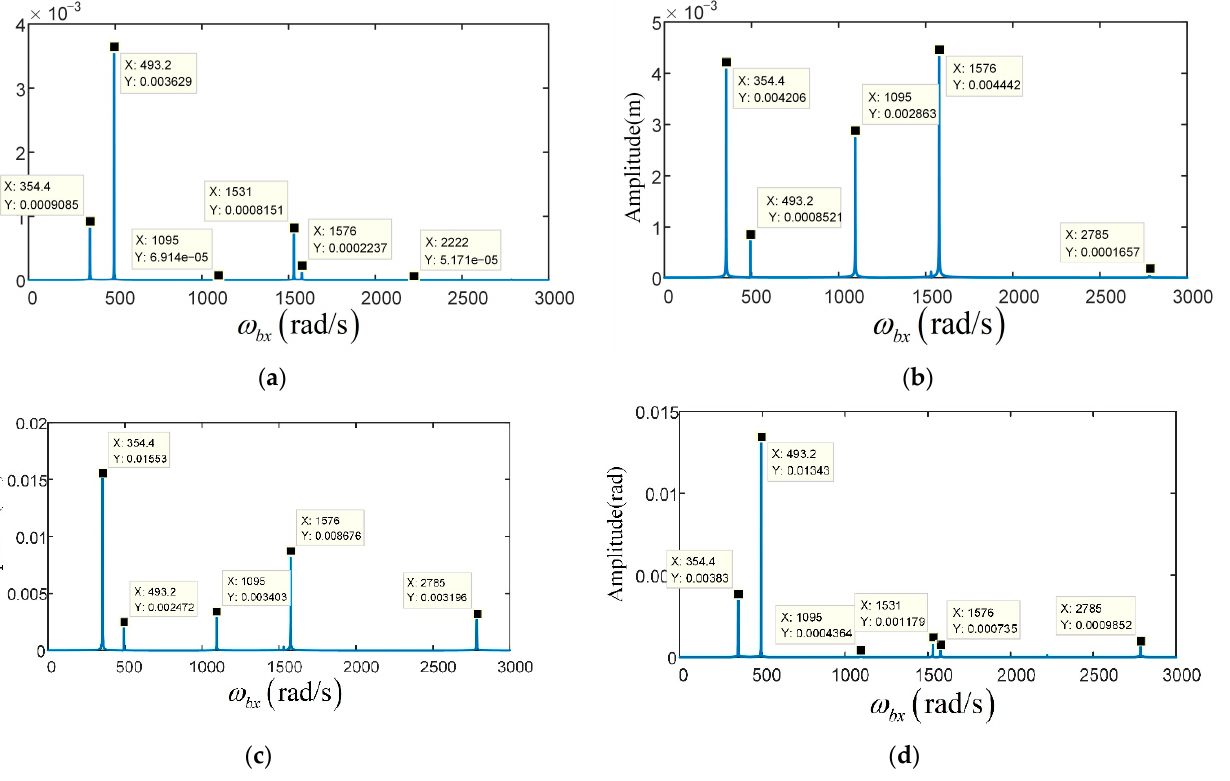
( d ) Figure 12. Responses of the dual-rotor system at disk 1 due to gravity with rolling base motion: ( a ) 𝑥 (cid:3031)(cid:2869) ; ( b ) 𝑧 (cid:3031)(cid:2869) ; ( c ) 𝜃 (cid:3031)(cid:2869) ; ( d ) 𝜓 (cid:3031)(cid:2869) . 4. Conclusions The combined effects of base motions, mass unbalance and gravity on vibration prop- erties of a counter-rotating dual-rotor system were studied in this paper for the first time. Some conclusions are summarized as follows: (1) Constant base rotations generated constant external stiffness and damping matri- ces, and so had some impact on its natural properties. The effects of rolling base motion are larger than that of pitching base motion. (2) When the base was fixed, mass unbalance on different rotors only excited whirling modes that were in the same direction with the rotor rotating. The constant pitching base